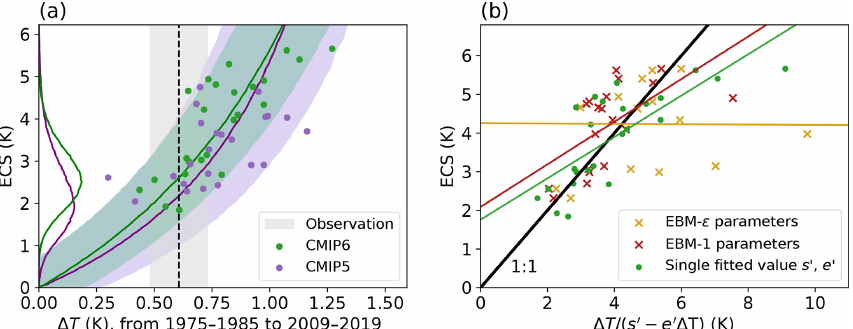
Figure 6. (a) Emergent constraint for ECS, using the functional form of Eq. (5). The shaded area includes the 5%–95% confidence interval. (b) Comparison of emergent constraint fitted parameters, using model values for s (cid:48) and e (cid:48) . The coloured lines are OLS fits for the three cases, and the black line indicates the 1 : 1 line. Three values for the EBM- (cid:15) model are not shown as their (cid:49)T/ ( s (cid:48) − e (cid:48) (cid:49)T ) values are between 75 and